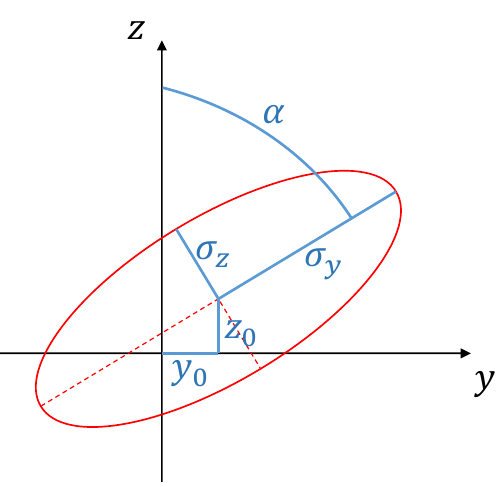
Figure 3. Schematic of the 2D-Gaussian fit function. The red line shows a contour line of the velocity deficit with the fit parameters in blue. The coordinate system is a right-hand Cartesian system with the x-axes pointing from the wind turbine in the downwind direction. The cross-section view has positive y values to the right and corresponds to an observer standing downstream of the turbine looking towards the turbine (i.e., looking against the direction of the x -axis). The schematic illustrates a tilted wake for clock-wise rotation of the wind direction with height, which is common in the